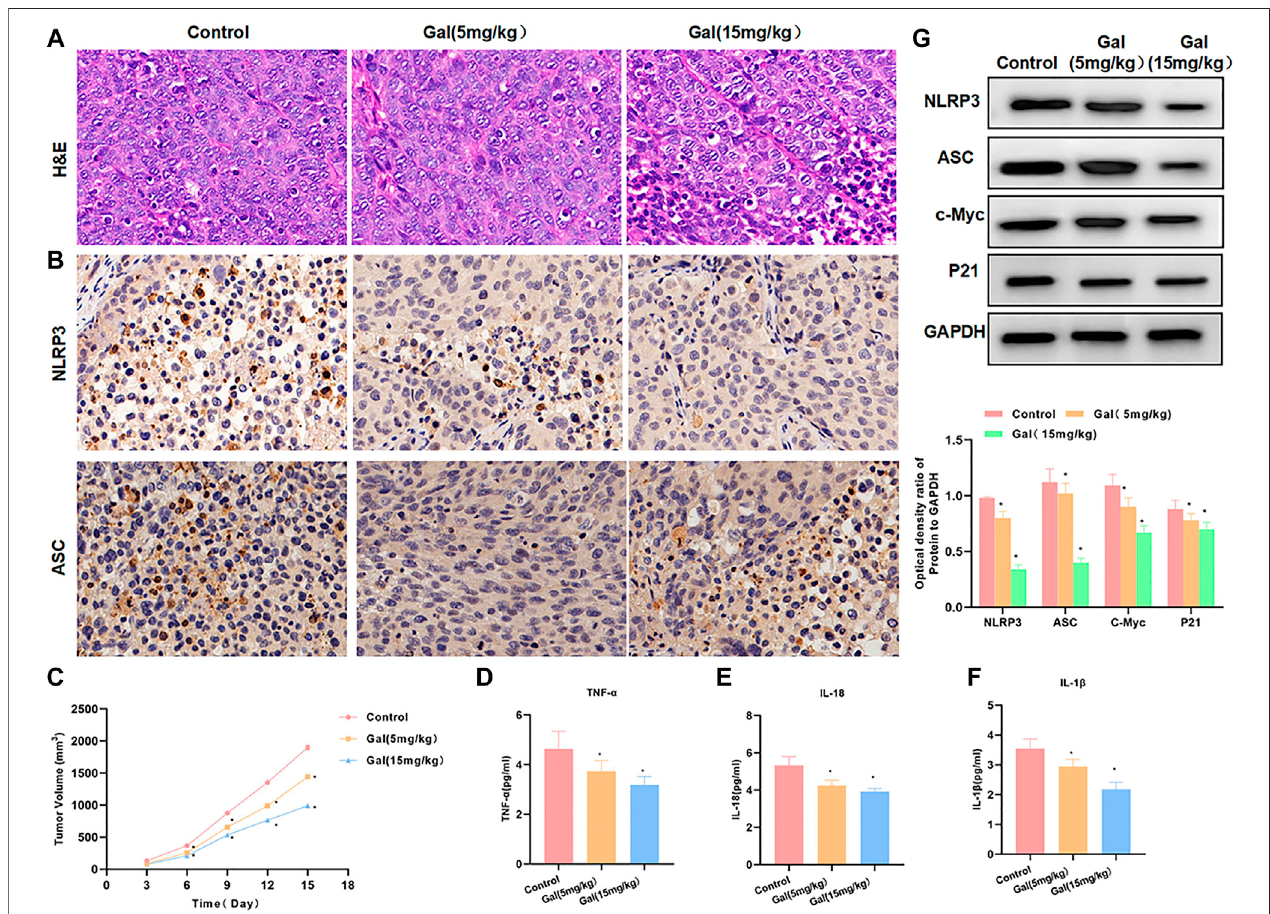
FIGURE 7 | Gallo fl avin inhibited tumor growth in tumor-bearing mice. (A) : H&E staining revealed that Gal could cause certain injury to the tumor tissue, which was obviouslychangedcomparedwith thecontrol group. (B) : Theexpression levelsofNLRP3 and ASC wererelativelyhigh intumor tissues.Gal could inhibit theexpression ofNLRP3andASC,andtheproteinlevelwassigni fi cantlydownregulated. (C) :ThedetectionofthetumorgrowthraterevealedGalcouldinhibittumorgrowth,whichwas signi fi cantly different from Control. Comparison with the Control group, * p < 0.05. (D – F) : Gal inhibited the level of in fl ammatory factors in the tumor, which was signi fi cantly lower than Control and relieved the in fl ammatory microenvironment. Comparison with the Control group, * p < 0.05. (G) : Detection of protein expression showed that Gal could inhibit the expression of NLRP3 and suppressed the levels of c-Myc and P21. Comparison with the Control group, * p < 0.05.